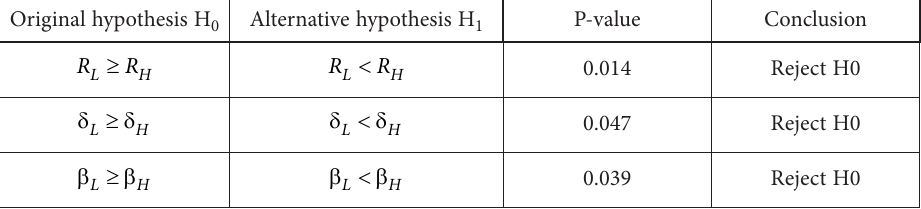
Table 8. Wilcoxon signed rank test